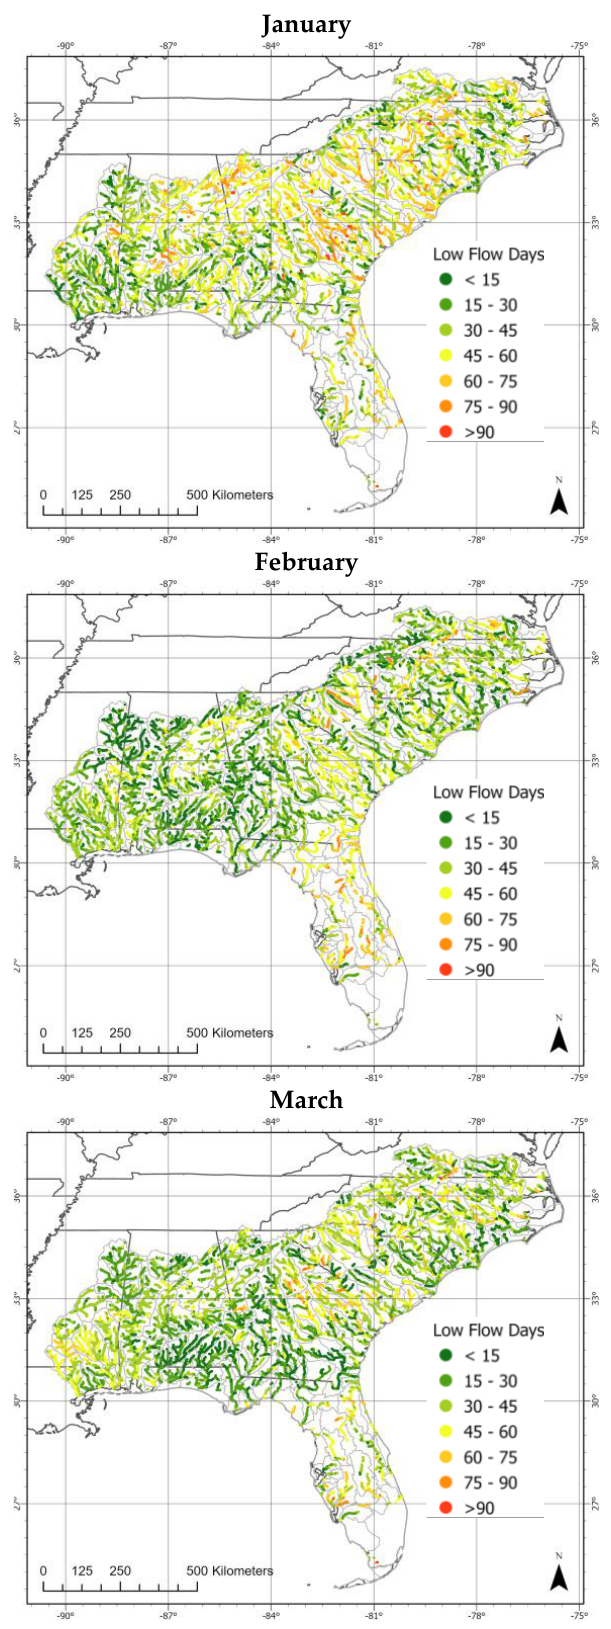
Figure 4. Cool season (January – March) patterns of low flow frequency (total number of 7Q10 days) over the study region based on NWM retrospective simulations.